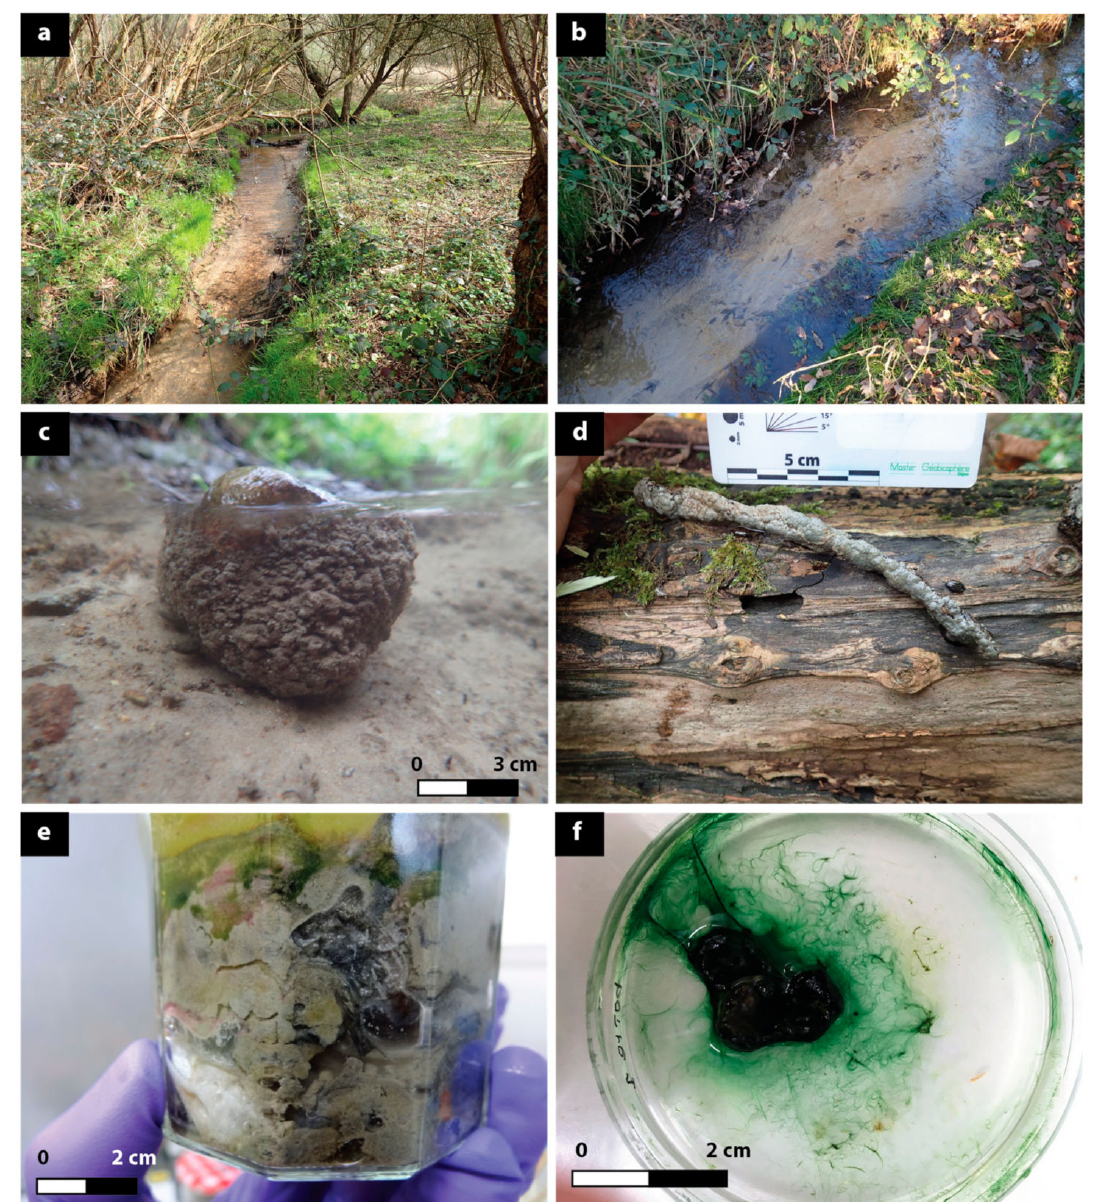
Figure 1. Images of ( a ) the sampling location in the stream (2 ◦ 07’16.48”E and 48 ◦ 43’06.03”N), located 21 km to the Southwest of Paris and ( b ) a close-up view of the stream showing fine-grained sediments and green biofilm to the right in the stream bed. Laminated microbial deposits encrusting ( c ) a pebble and ( d ) a wooden stick; ( e ) the Winogradsky column filled with shredded paper (bottom left), microbial mat and sediments; the column was deployed to enrich for a cyanobacterial biofilm used in the laboratory experiment and ( f ) a cyanobacterial biofilm on a soft agar surface in a Petri dish (second stage of enrichment (see Section